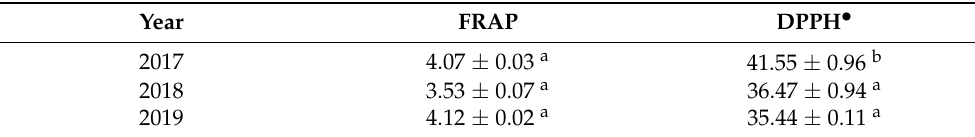
Table 4. Antioxidant capacity by Ferric Reducing Antioxidant Power Assay (FRAP) and 2,2-diphenyl- 1-picrylhydrazyl (DPPH • ) assays of calafate berry for three consecutive years (2017, 2018 and